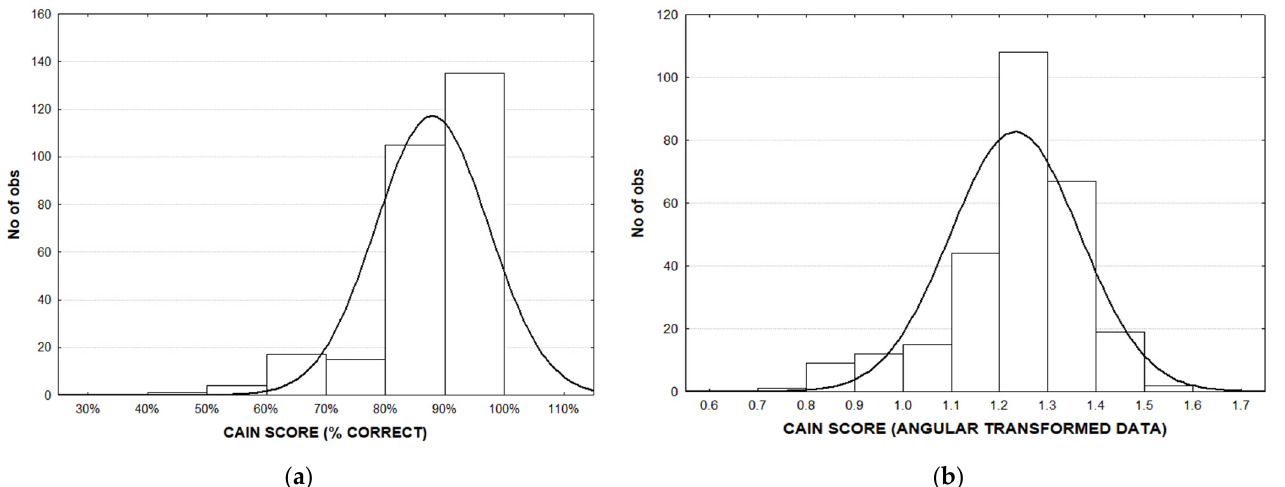
Figure 1. ( a ) Distribution of the CAIN scores. The line indicates the expected normal distribution; ( b ) Distribution of the CAIN scores (angular transformed data). The line indicates the expected normal distribution.